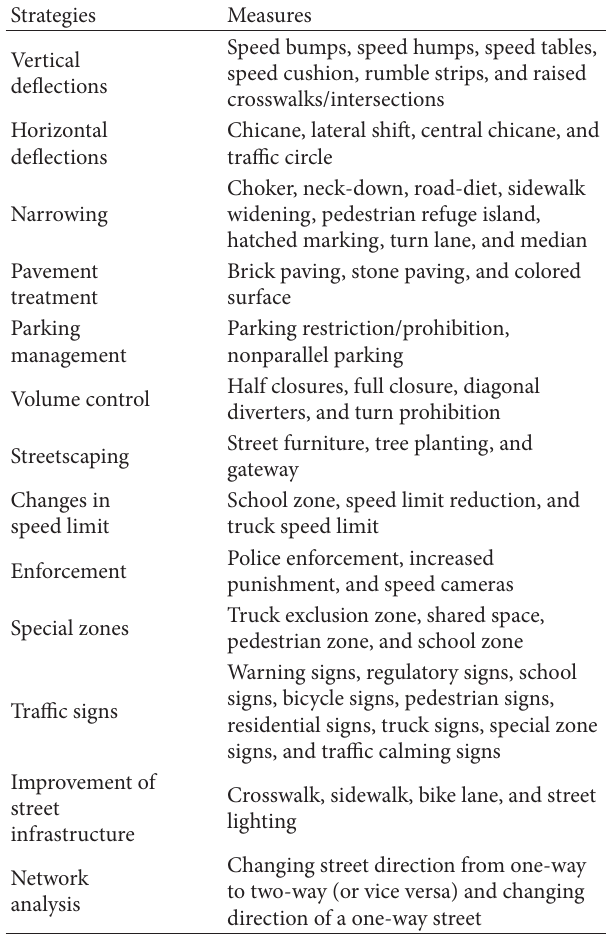
Table 2: Classification of traffic calming